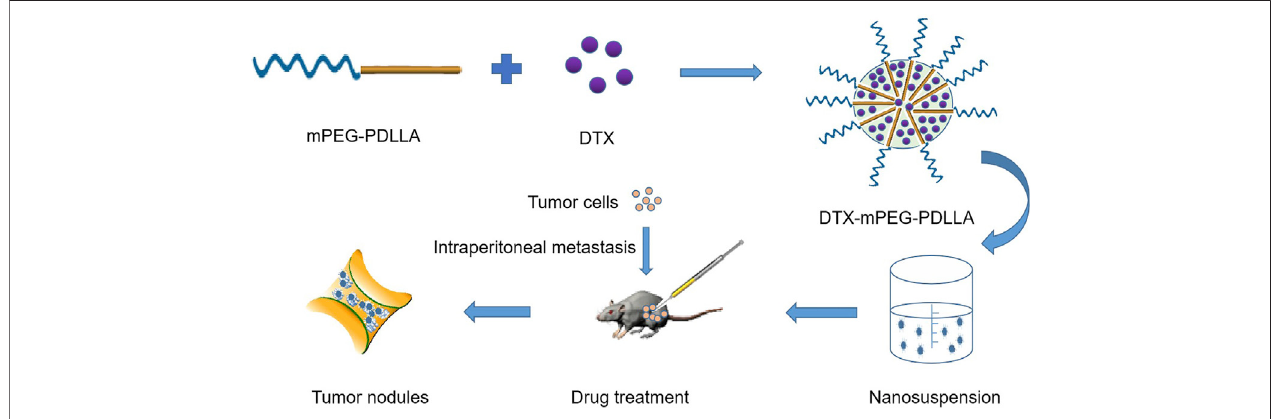
FIGURE 1 | Schematic of the synthesis and intraperitoneal administration of DTX-mPEG-PDLLA micelles. The DTX-mPEG-PDLLA micelles were prepared with DTX and mPEG-PDLLA polymers by a self-assembly method. The drugs were delivered by the micelles after IP administration for an antitumor effect in vivo .